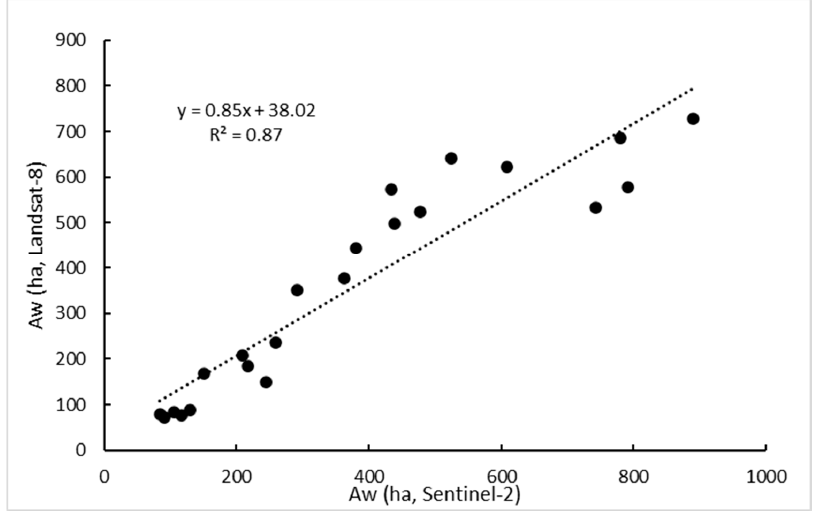
Figure 6. Comparison between water areas derived from Landsat-8 and Sentinel-2A/B images in the period 2015–2021.